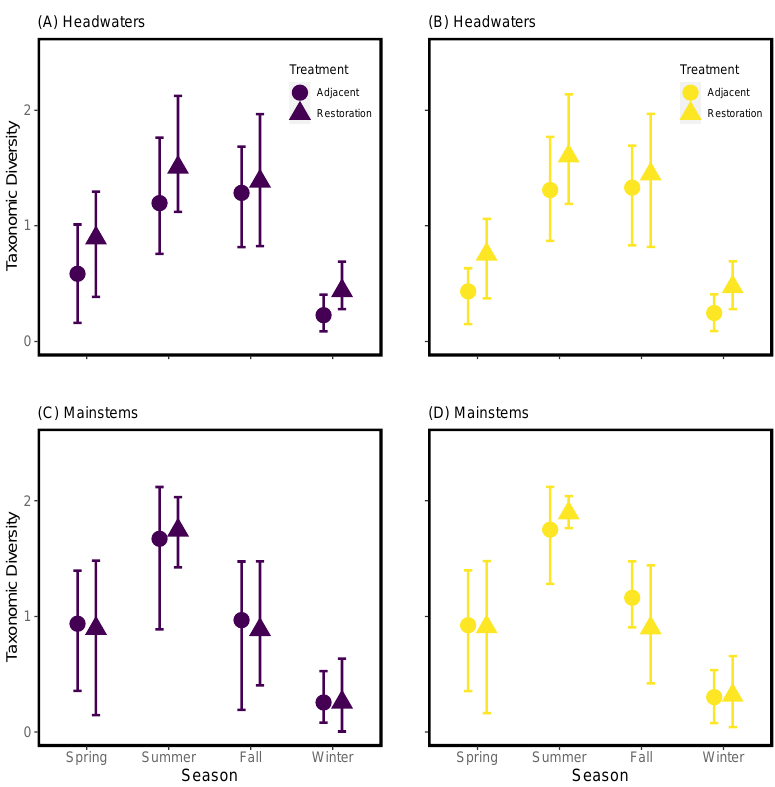
Figure 2 : Plots of taxonomic diversity, calculated as Shannon’s diversity, in headwaters (A and B) and mainstems (C and D). Taxonomic diversity is reported for restored (triangles) and adjacent (circles) sites; values from the full sites are reported in purple (A and C), while those from the revised sites are reported in yellow (B and D). Points represent mean ± 95% CI.